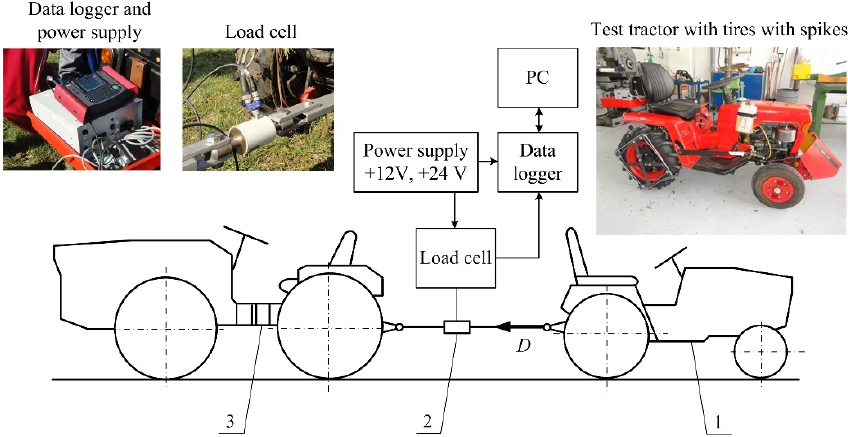
Figure 5. The system for measuring the drawbar pull of the tractor at 100% wheel slip: 1—test tractor; 2—force sensor; 3—load tractor; D —drawbar pull.